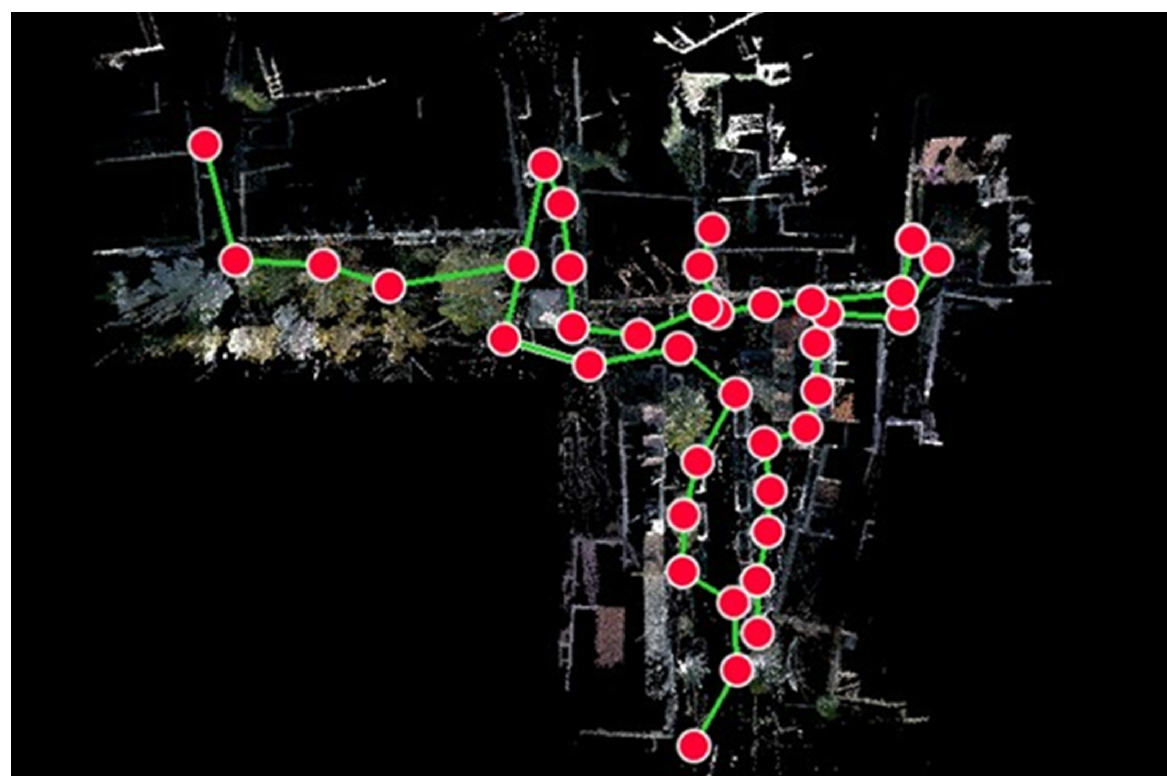
Figure 9. Plan view of the point cloud showing camera stations.